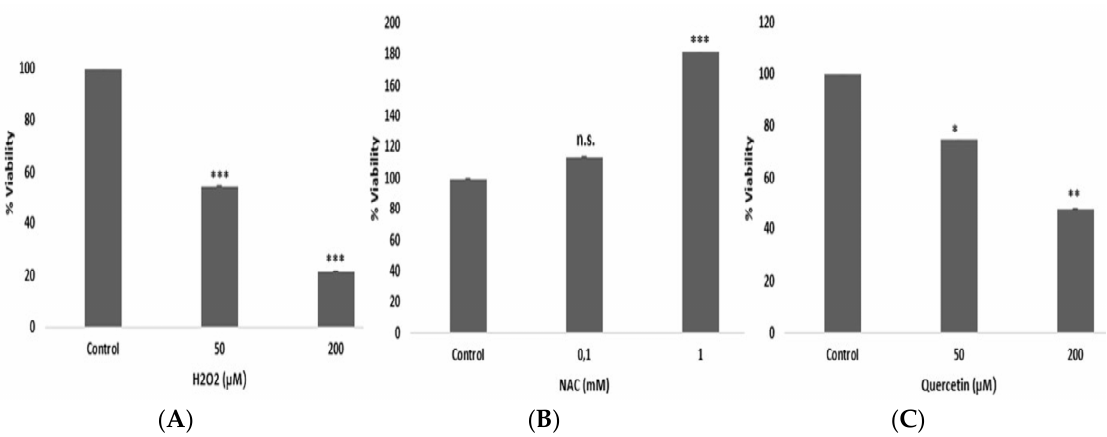
Figure 1. Percentage viability of HepG2 cells treated with H 2 O 2 ( A ), N -acetyl cysteine ( B ), and quercetin ( C ). * p < 0.05 vs. control; ** p < 0.01 vs. control; *** p < 0.001 vs. control